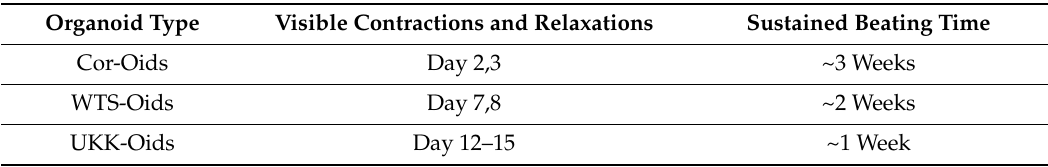
Table 4. The organization of organoids depends on their sustained beating